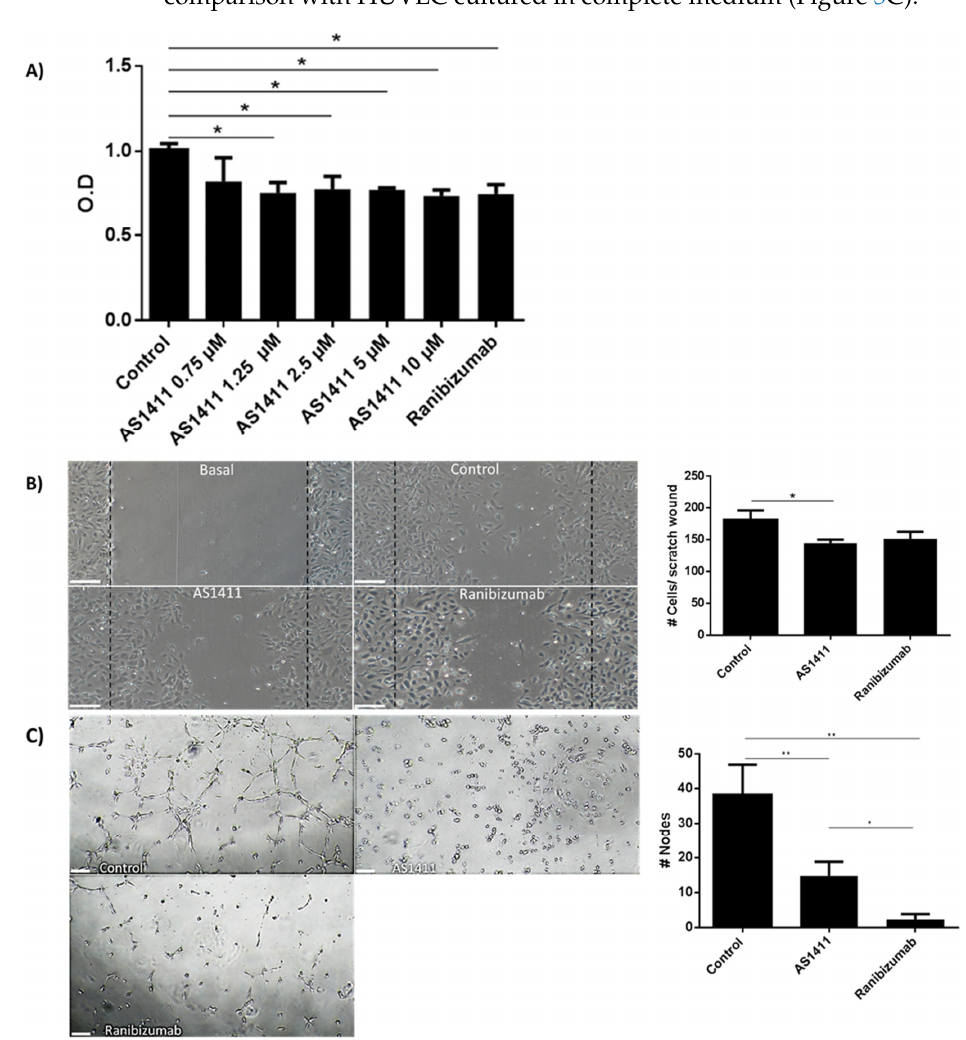
Figure 5. AS1411 reduced HUVEC proliferation, migration and tube formation. ( A ) HUVEC proliferation assay. AS1411 nucleolin-binding aptamers (1.25–10 μ M) significantly inhibited HUVEC proliferation. These effects were not dose de- pendent. As expected ranibizumab inhibited HUVEC proliferation due to VEGF dependent effects over HUVEC. ( B ) HU- VEC migration was performed by means of an in vitro scratch assay. Control group was able to significantly induce HU- VEC migration due to the growth factors present in the F-12K medium. In contrast, AS1411 (10 μ M) were able to signifi- cantly reduced HUVEC migration induced by F-12K medium. Similarly, ranibizumab was able to significantly reduced HUVEC migration induced by F-12K. Graphical representation demonstrating that both AS1411 (10 μ M) and ranibizumab were able to significantly reduced HUVEC migration in HUVEC. ( C ) HUVEC tube formation assay. Tube formation was significantly inhibited by AS1411 (10 μ M) and ranibizumab in comparison to the control group. Bars represent mean (± SE) of 3 independent assays. * p < 0.05 and ** p <0.01.